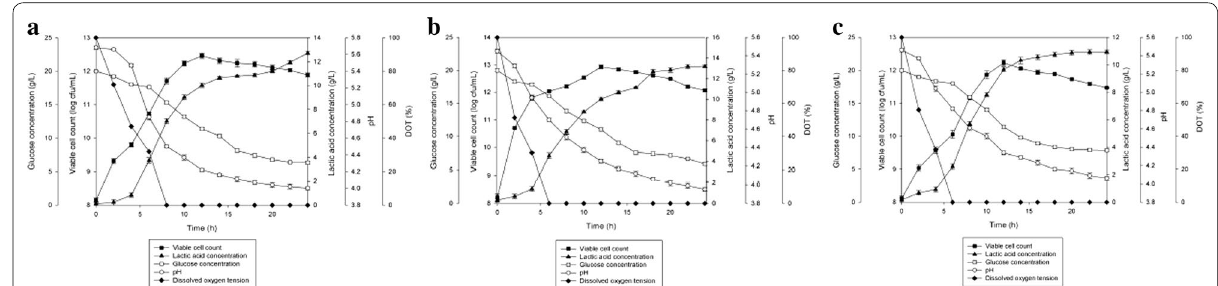
The results presented are the average of triplicate experiments and are expressed as mean a,b Mean values in the same row with different superscripts are significantly different from each other (P < 0.05)